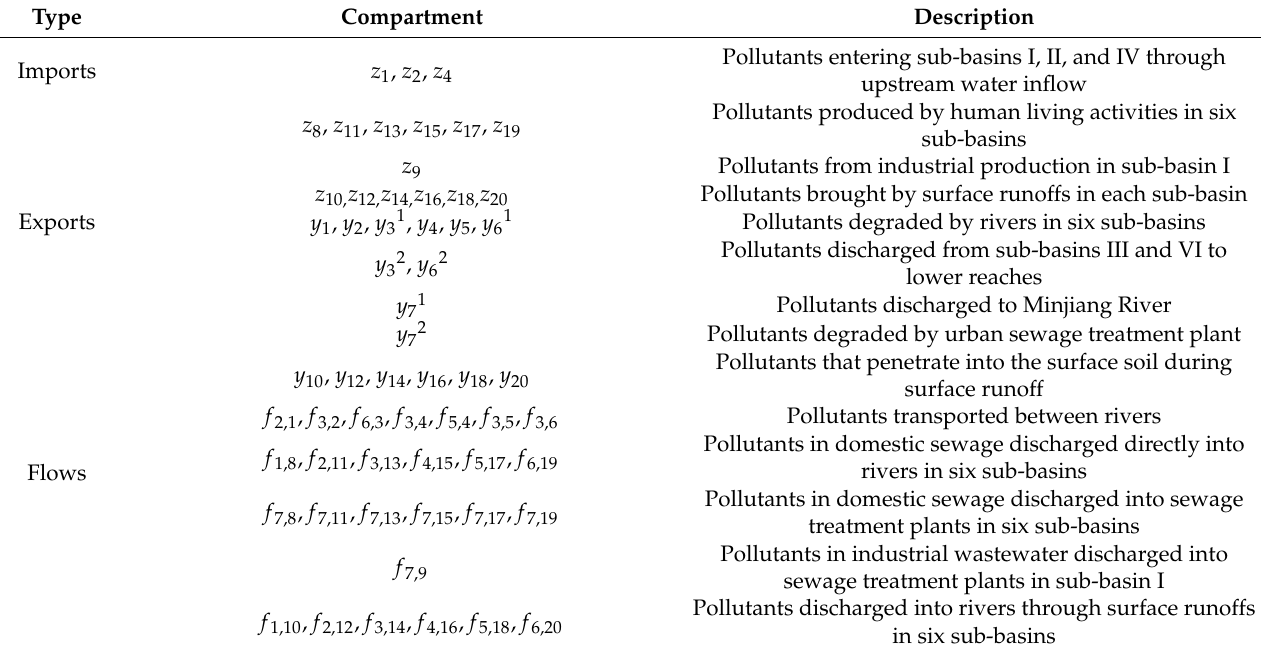
Table 5. Description of imports, exports, and flows between compartments in the water pollutant metabolism network model for the study